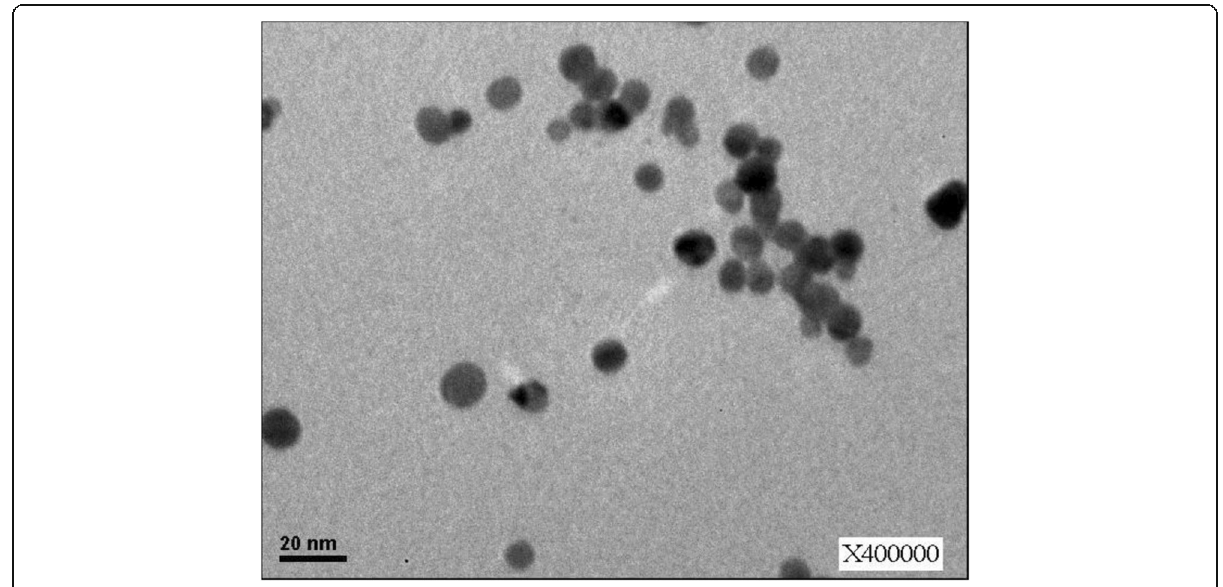
Fig. 2 TEM image of spherical citrate-stabilized silver nanoparticles at 400,000X